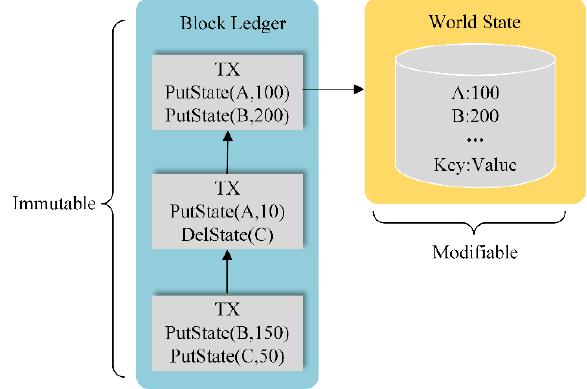
Figure 3. Ledger and database in blockchain.